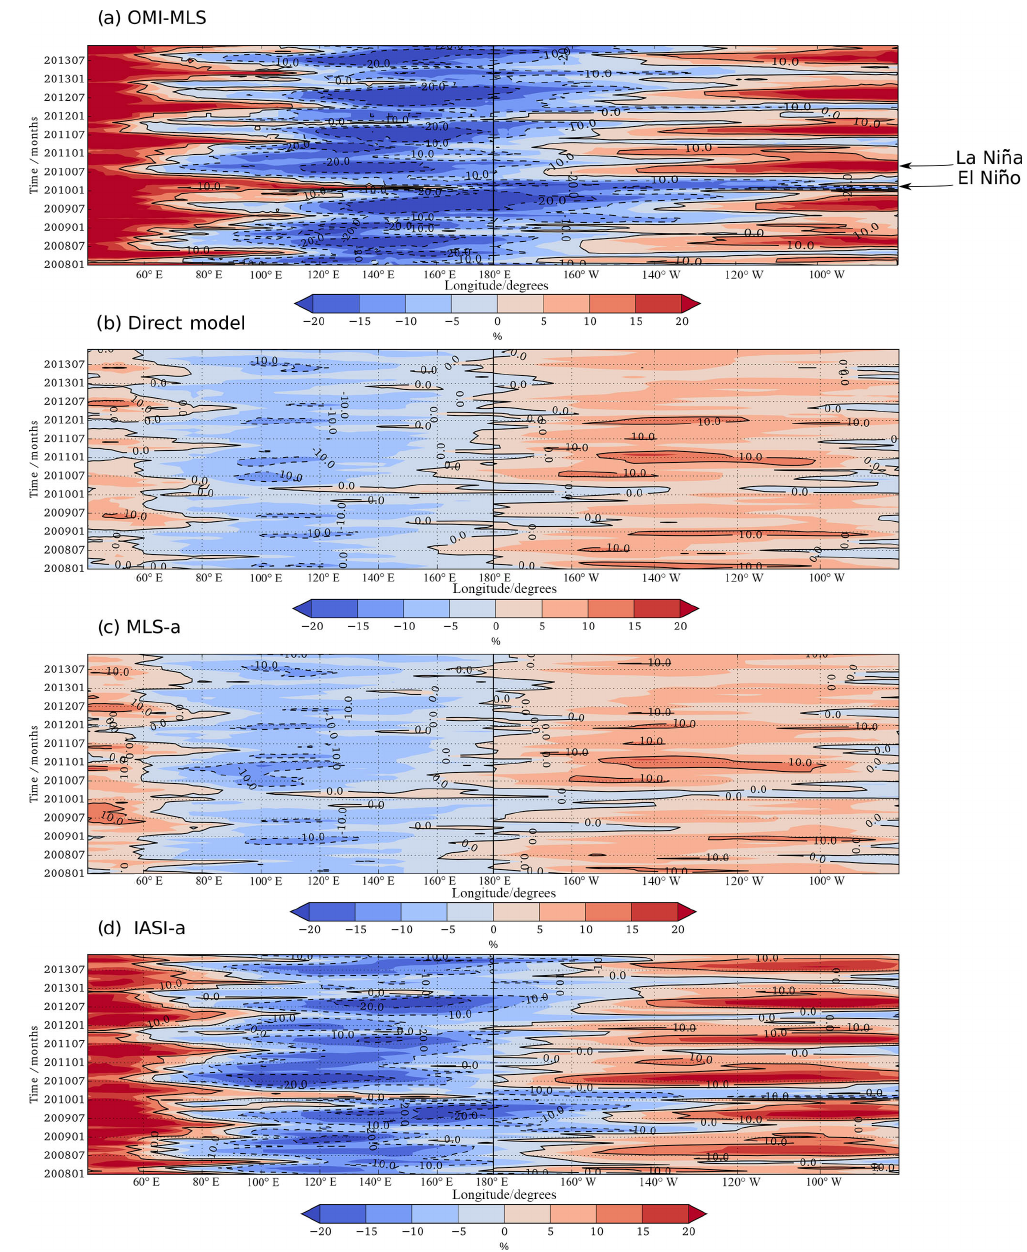
Figure 6. Longitude Hovmöller diagrams of TCO anomalies for (a) OMI-MLS measurements, (b) Direct Model, (c) MLS-a and (d) IASI-a between 2008 and 2013. Longitudes are identical to Fig. 5: between 40 ◦ E and 80 ◦ W. Anomalies are expressed in